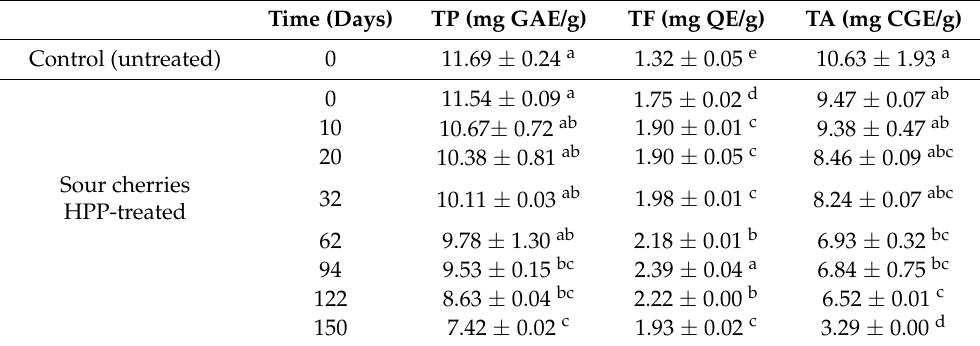
Different letters in columns indicate significant differences ( p < 0.05) among mean